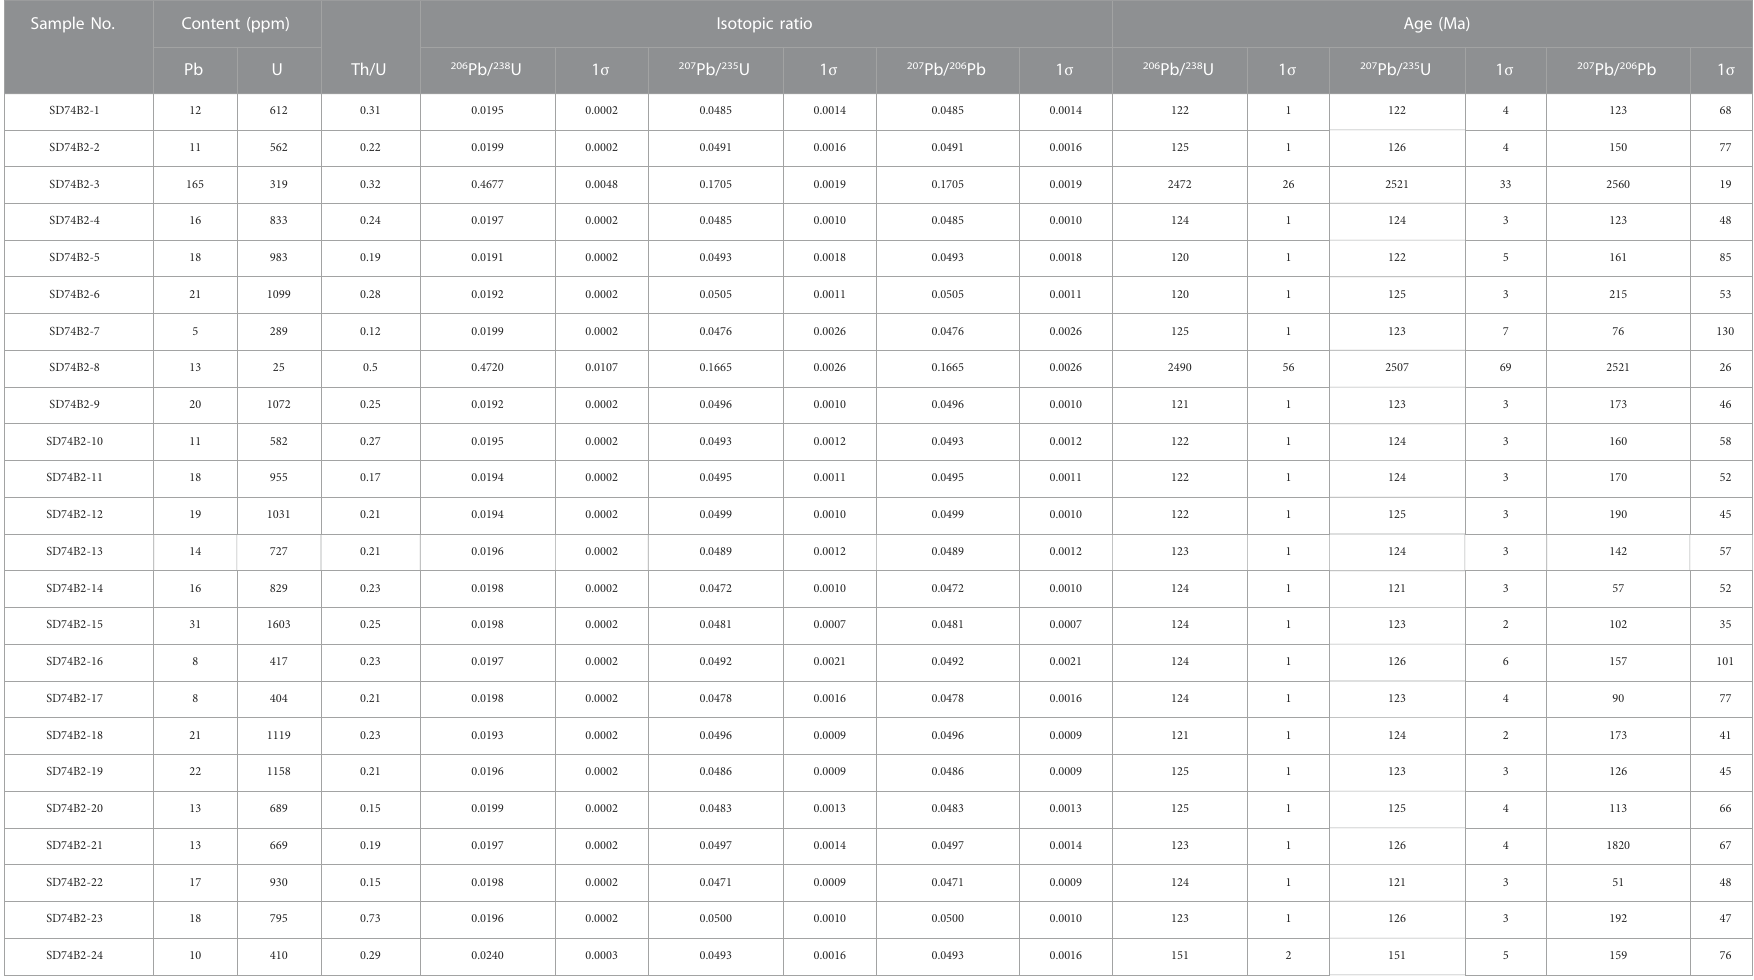
TABLE 5 LA-ICP-MS zircon U-Pb data for the quartz diorite porphyrite dyke. Sample